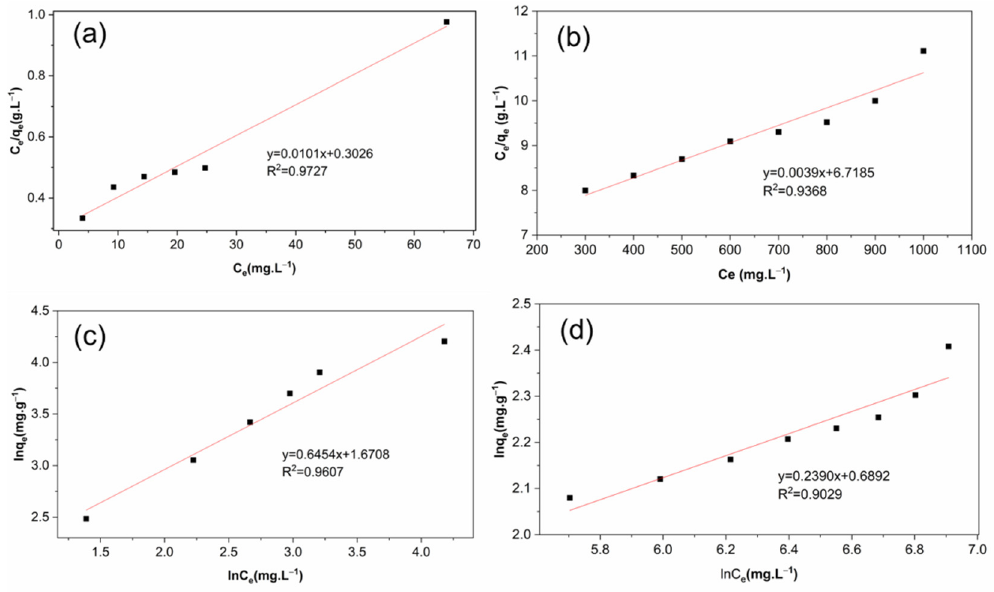
Figure 6 . Fitting experimental data of Langmuir ( a , b ) and Freundlich ( c , d ) isotherms for ( a , c ) MB and ( b , d ) Cu (II) ions interaction to the HGC-2 beads. Experimental conditions: adsorption time of 120 min, 100 mg of dried HGC-2 beads, 100 mL solution, pH 8.0 (MB), or pH 5.0 (Cu(II) ions) under room temperature. Table 2. Parameters of the fitting Langmuir and Freundlich isotherms for the adsorption of MB and Cu(II) ions onto the HGC-2 sample.